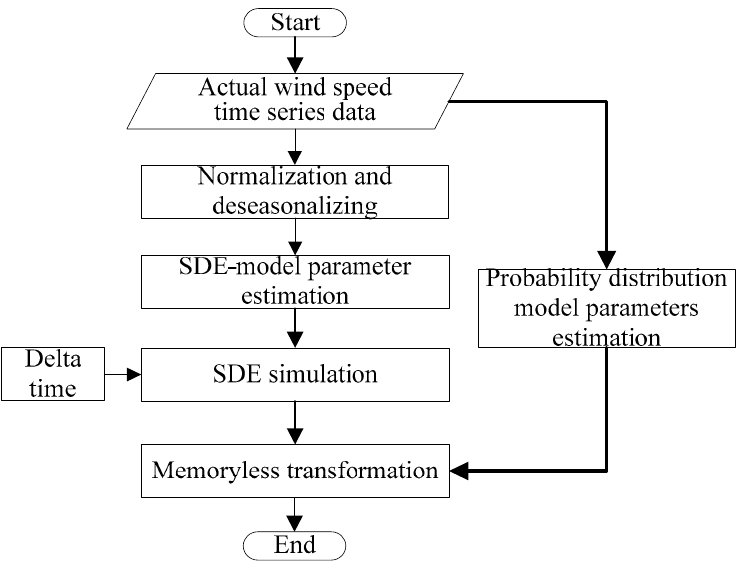
Figure 1. Wind speed simulation flowchart.